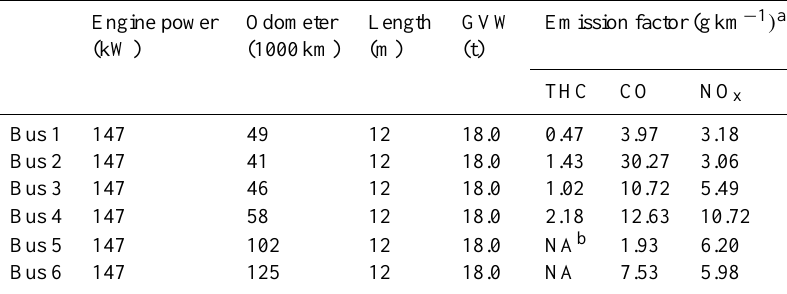
and (d) PM for Euro II, Euro III 5 X 2.5